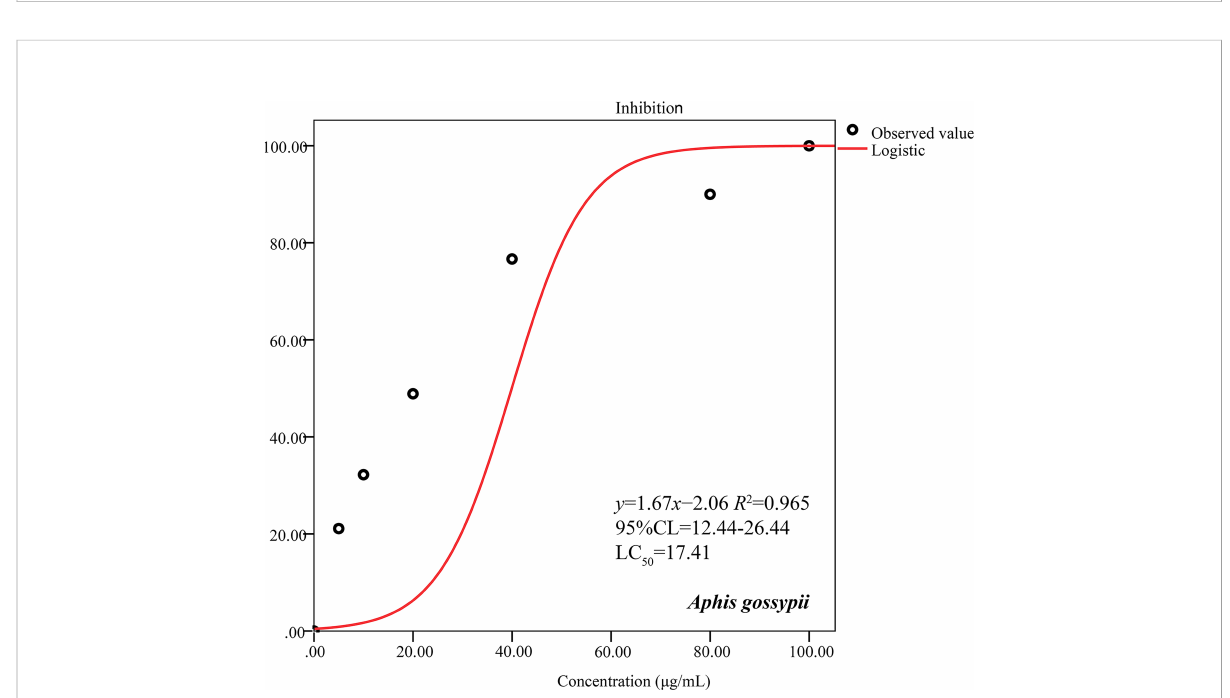
FIGURE 3 Dose – response curves of A. tibetica EO against A. gossypii adults. R 2 adj: adjusted coef fi cient of determination. LC 50 : 50% lethal concentration of A. gossypii . 95% CL: 95% con fi dence